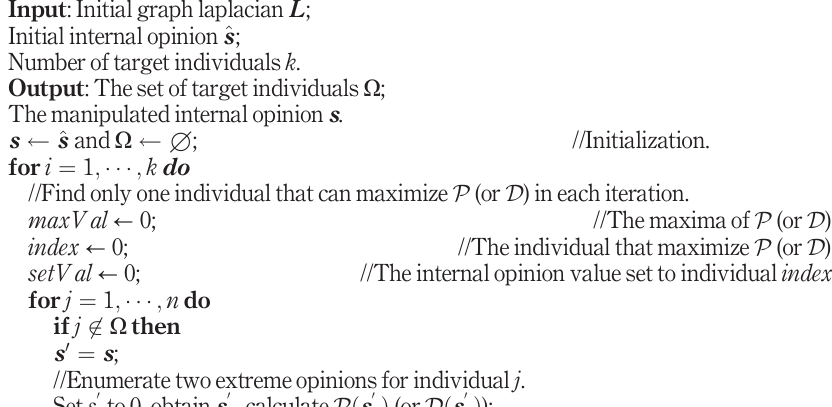
Algorithm 2: Greedy algorithm for maximizing polarization or